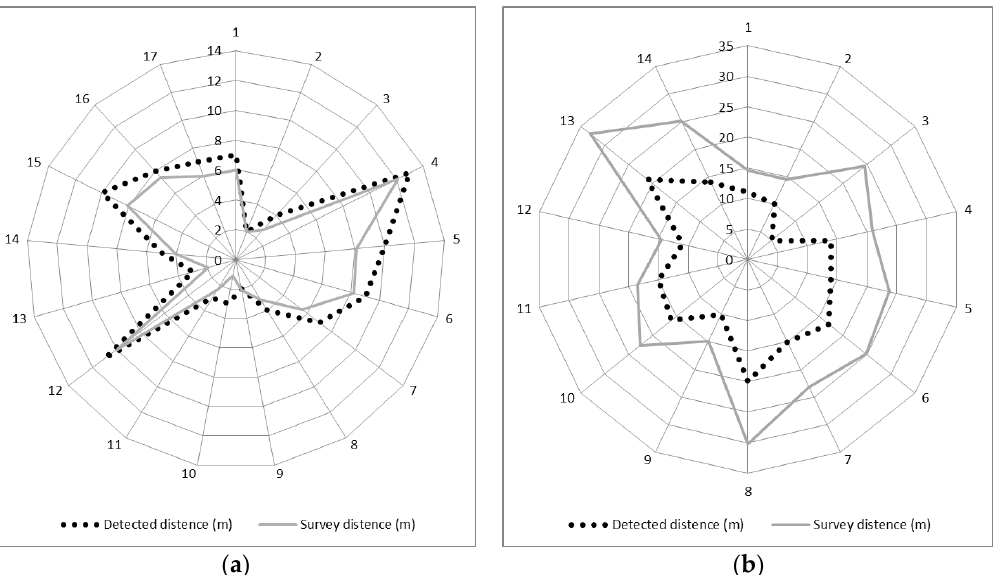
Figure 14. The comparison of ( a ) detected crossings, distance with manual inspection and ( b ) detected turnouts, distance with manual inspection in Kusatsu line.